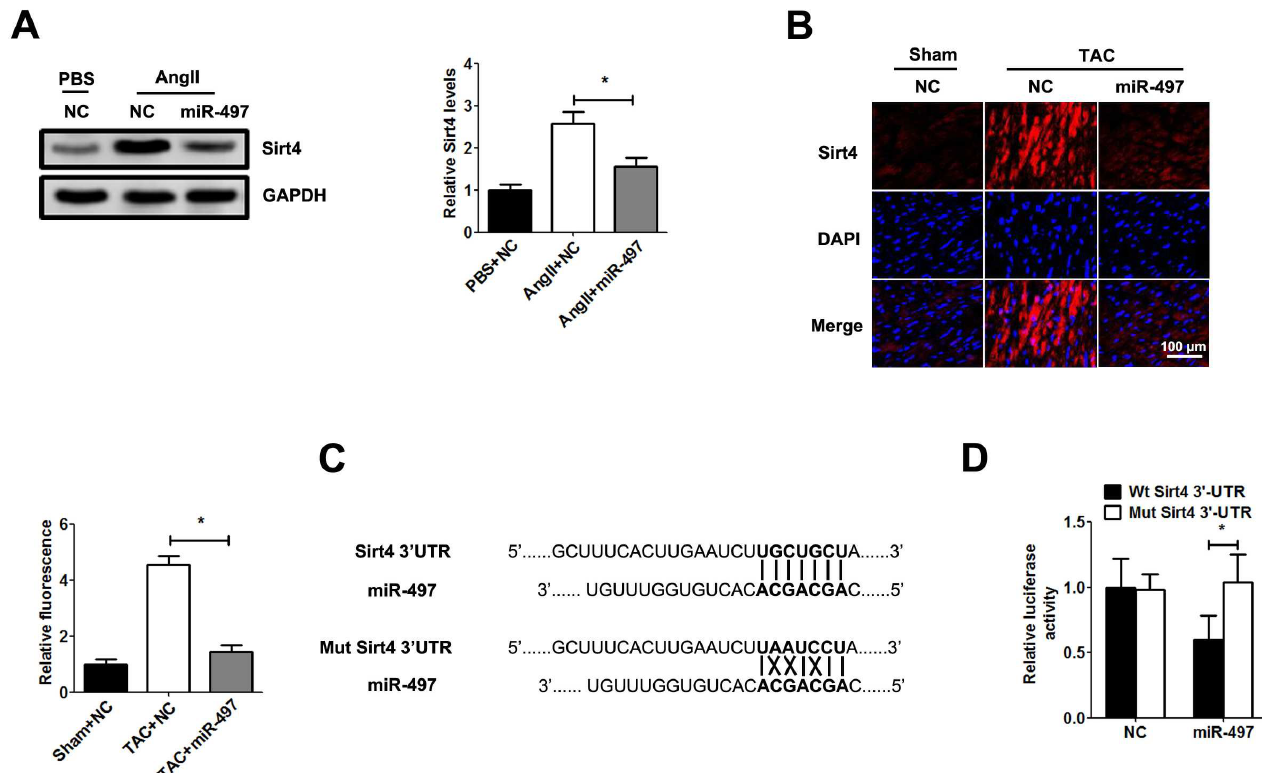
Fig 4. miR-497negatively regulates Sirt4 expression. a: The expressionof Sirt4 was detected by western blot in primary cardiomyocytes after infectionwith Leti-miR-497 or Leti-NC (MOI = 50) for 48 h. b: Immunofluorescence assay of Sirt4 expressionin cardiac tissues after infection with Leti-miR-497 or Leti-NC (3.5 × 10 7 viral particlesper mice). c: The potential bindingsequencein 3’UTR of Sirt4 and a mutant sequencewere cloned into the pMIR luciferase vector. d: Primary cardiomyocytes were transfected reporter plasmidand were infected Leti-miR-497for 48 h. Relative luciferaseintensity was determinedwith a luciferaseassay. Data are presentedas the mean ± SD; * , P < 0.05, n = 5.